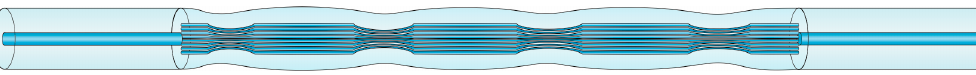
Figure 13. Schematic of singlemode-periodically tapered PCF-singlemode fiber structure.